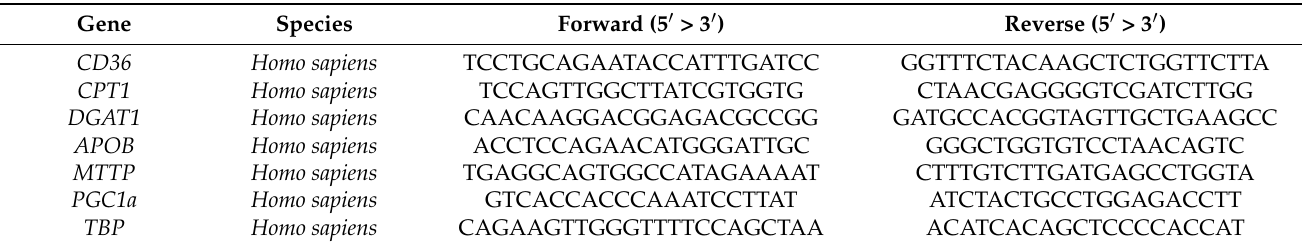
Table 2. Primers used in this